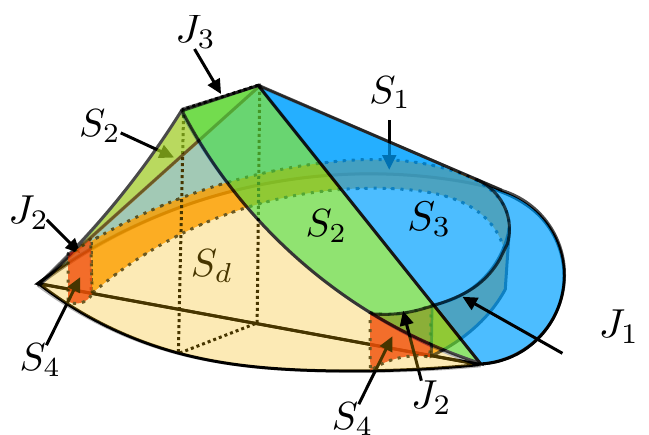
Figure 7. Various joint and surface contributions to the action of the WDW patch. We have focused on the future half of the patch on one side of the